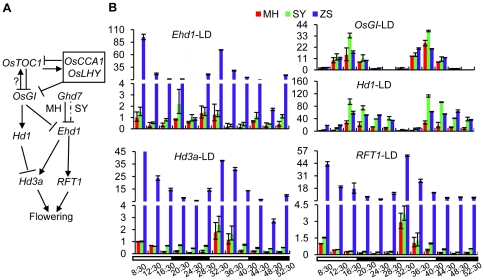
Diurnal expression of rice key flowering time genes under long day conditions.(A). Model for heading date genetic control pathways in MH63 and SY63 under long day conditions. Bars, repression; arrows, activation. Dashed lines indicate reduced activity in SY63. (B). Diurnal expression patterns of Ehd1, OsGI, Hd1, Hd3a and RFT1 in SY63, MH63 and ZS97 under long day condition. In all panels, the mean values of each point are based on the averages of three biological repeats calculated using the relative quantification method. Values relative to MH63 at 8:30 (set arbitrarily as 1) are presented. Light and dark periods are indicated by white and black, respectively. Time points of the subjective day for sample harvesting are indicated. Error bars, s.e.m. from 3 biological repeats.